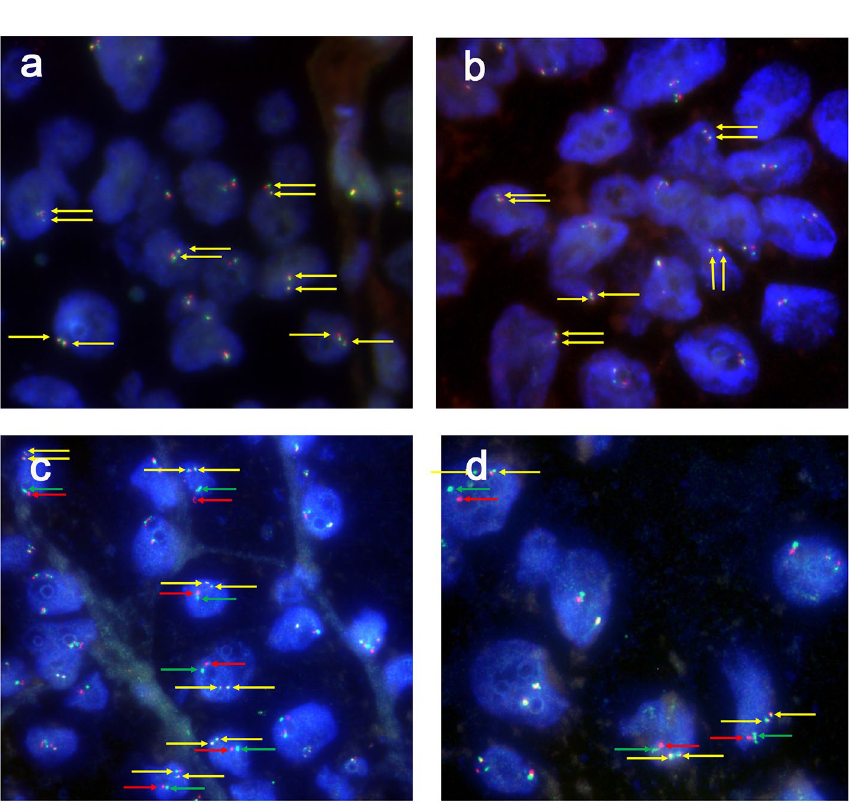
Figure 3. ( a , b ) show typical positive results of NONO-TFE3 dual-fusion FISH assay in males (2F, yellow arrowheads); ( c ) and ( d ) show typical positive results of NONO-TFE3 dual-fusion FISH assay in females (2F1G1R, yellow, red and green